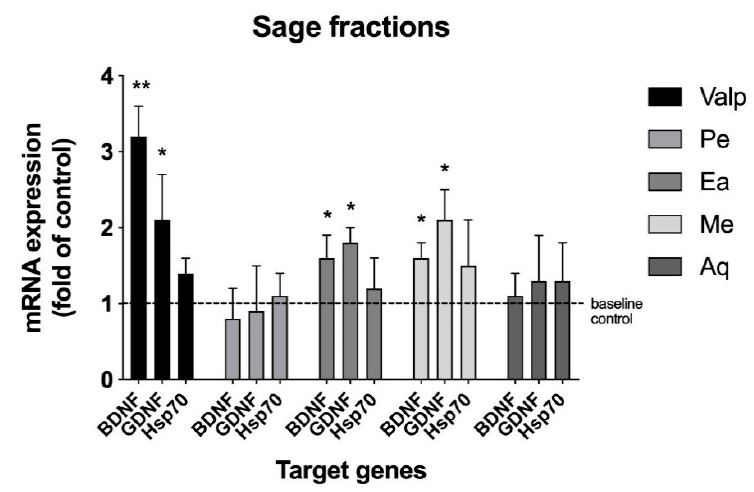
Figure 1. Sage extract modulation of neurotrophin transcription in C6 glioma cells. Sequential solvent fractions Pe (pentane), Ea (ethyl acetate), Me (methanol), and Aq (water) were screened at an initial concentration of 50 μ g/mL in triplicate. Results were expressed as a fold change of the control. Valproic acid (Valp) was used as the positive control. * p < 0.05, ** p < 0.01 versus vehicle control by Tukey's multiple comparison test.